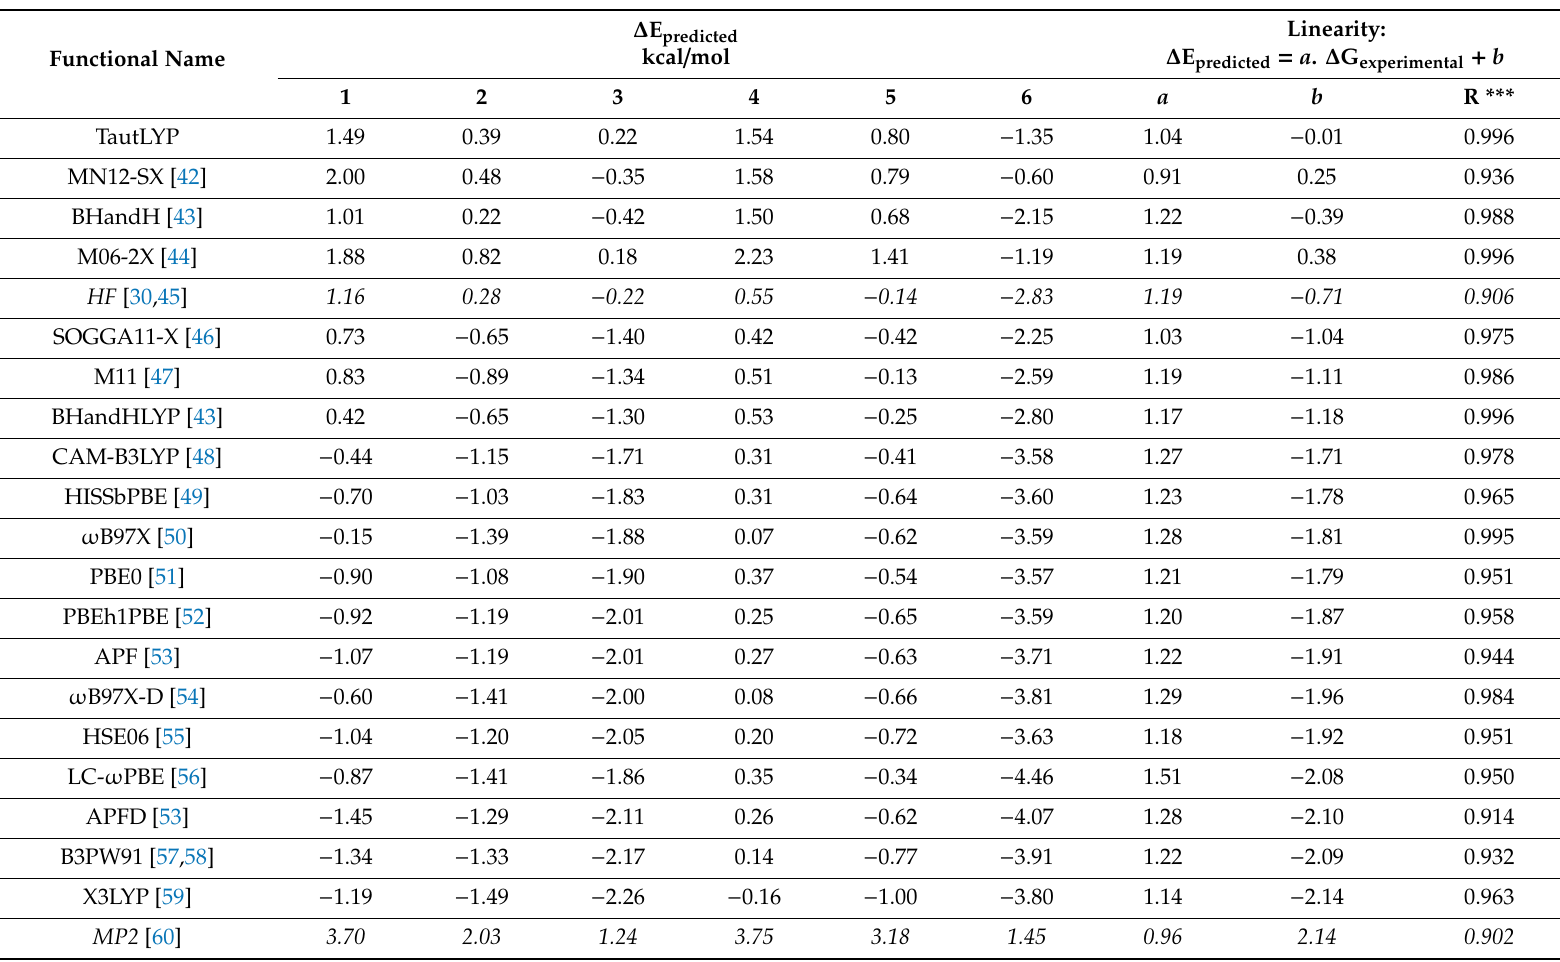
Table 1. Experimental ( ∆ G experimental ) and predicted relative stabilities ( ∆ E predicted ) * of the tautomers of 1 – 6 in cyclohexane